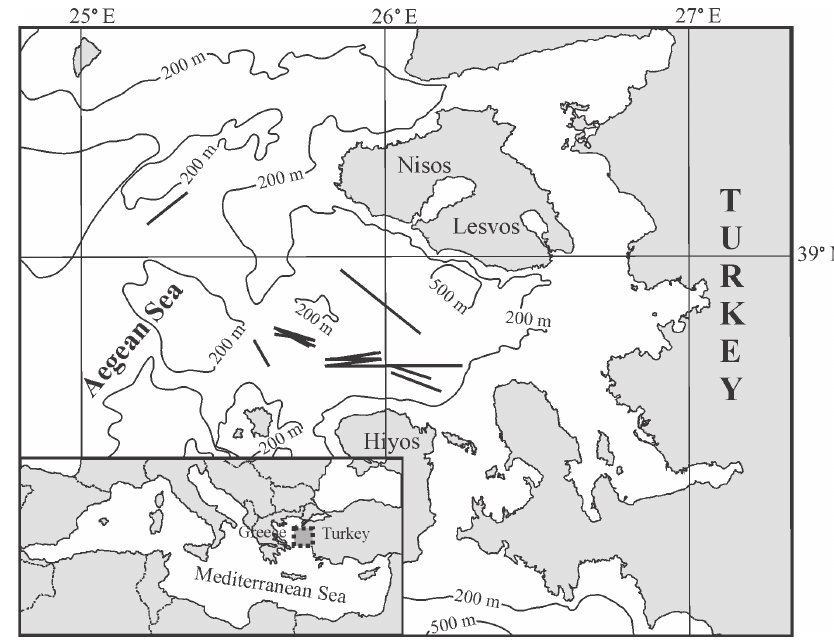
Fig. 1. – Map of the study area showing the fishing grounds of the aegean